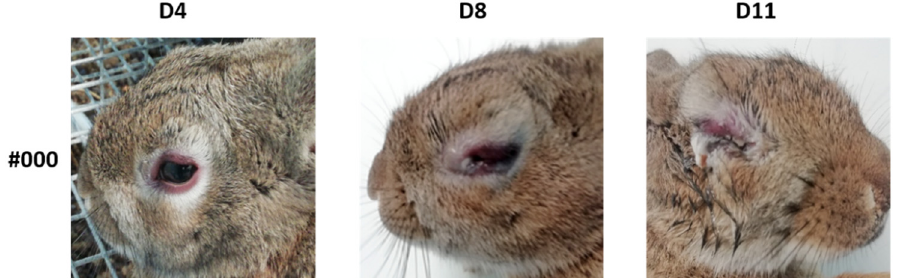
Figure 4. The clinical course of rabbit #000 (non-vaccinated, belonging to group R-G1) inoculated with virus isolated from Iberian hare (1 mL of 1000 ffu/mL, 38455PT18). D-day after challenge. Note very mild (D4), moderate (D8) and (D11) marked eyelid oedema. In rabbits, it took an average of 5.25 ± 1.5 days from the onset of symptoms until death occurred, and an average of 11.5 ± 0.56 days from the virus challenge until death, with an average weight loss of 73.5 ± 45.0 g. None of the vaccinated rabbits showed symptoms of myxomatosis (Table 4).